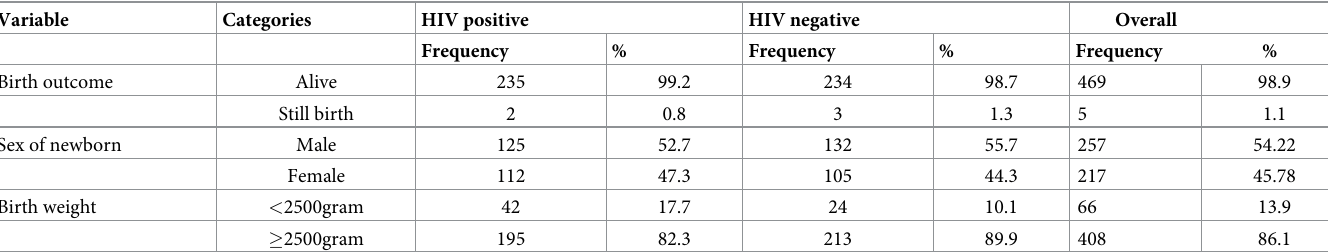
Table 4. Birth outcome in Northwest Amhara regional state referral hospitals (N = 474). Variable